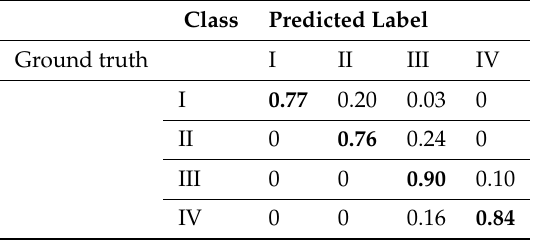
Table 4. Confusion matrix of breast density estimated based on thresholding rules.